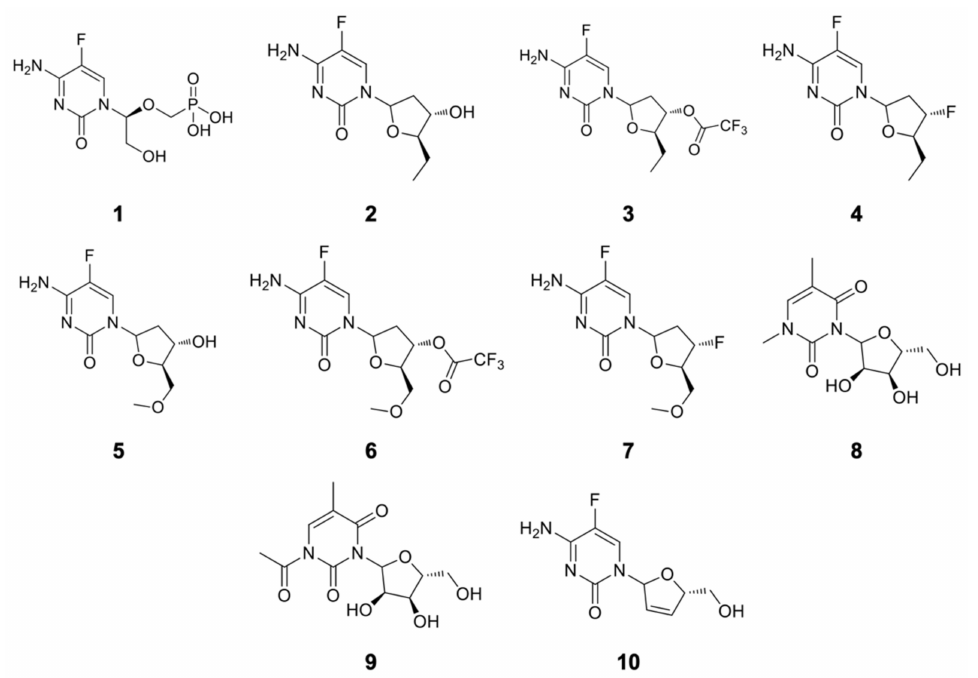
Figure 7. Structures of the studied